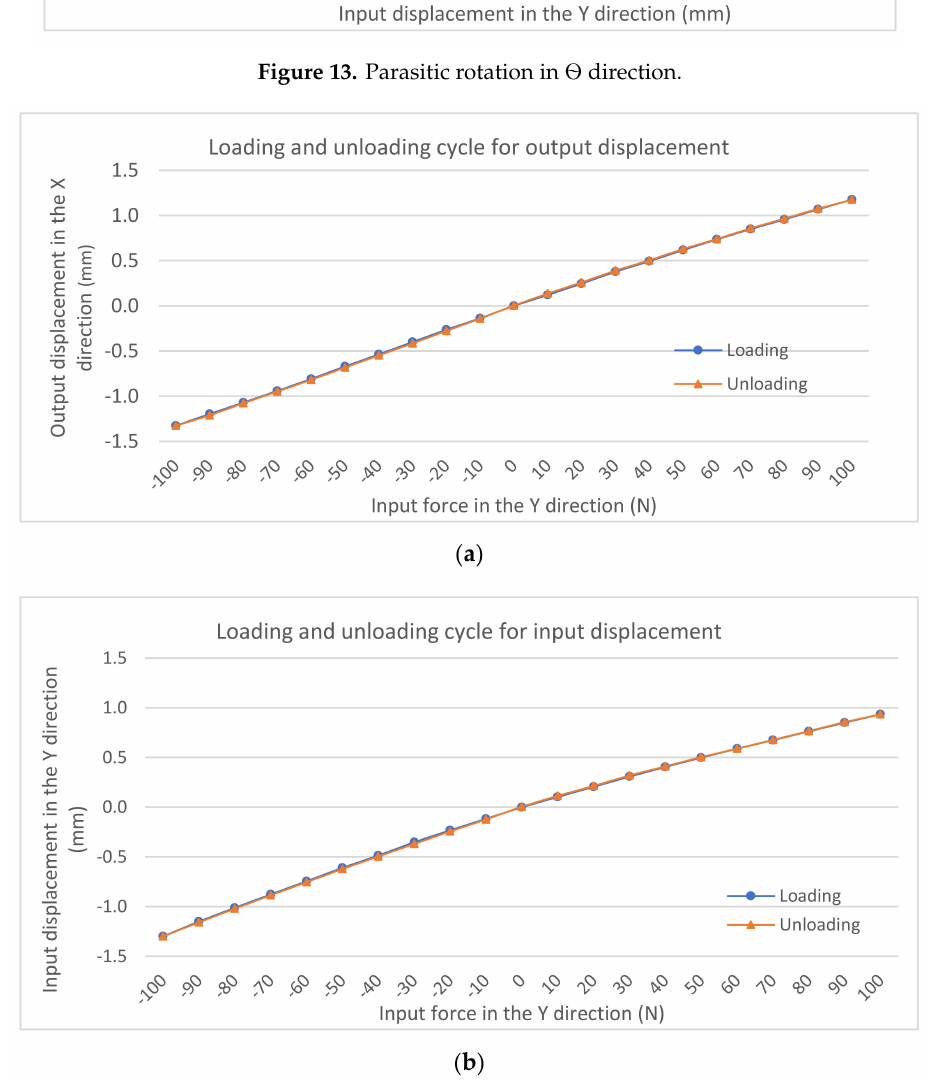
Figure 14. Hysteresis analysis. ( a ) output; ( b )